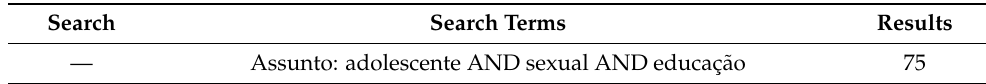
Table A8. Search at RCAAP in 6 April 2021.